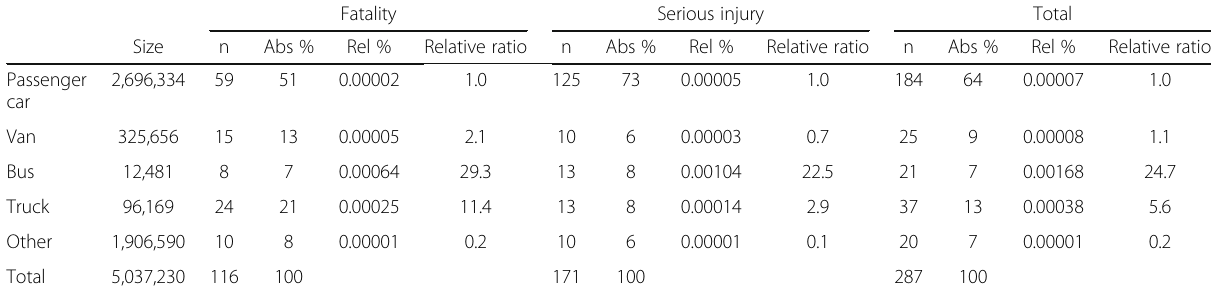
Table 1 Involved vehicle type ( n = 287) according to pedestrian fatality and serious injury Fatality